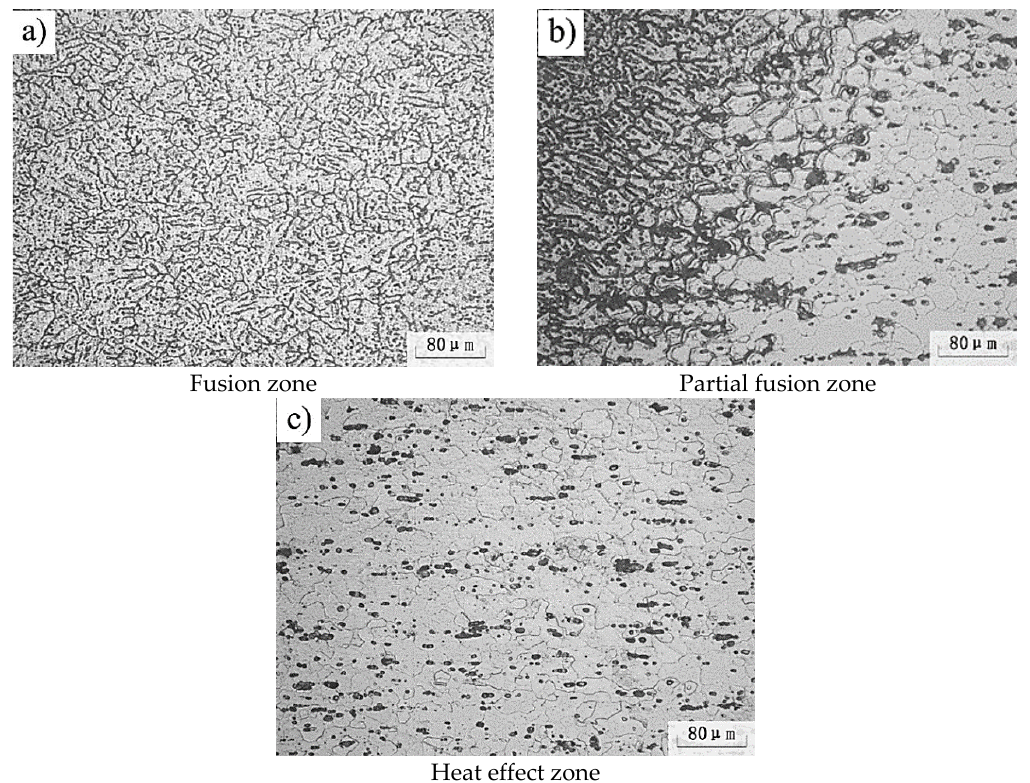
Figure 6. Optical microscopy of hybrid welding 6061-T6 joints.